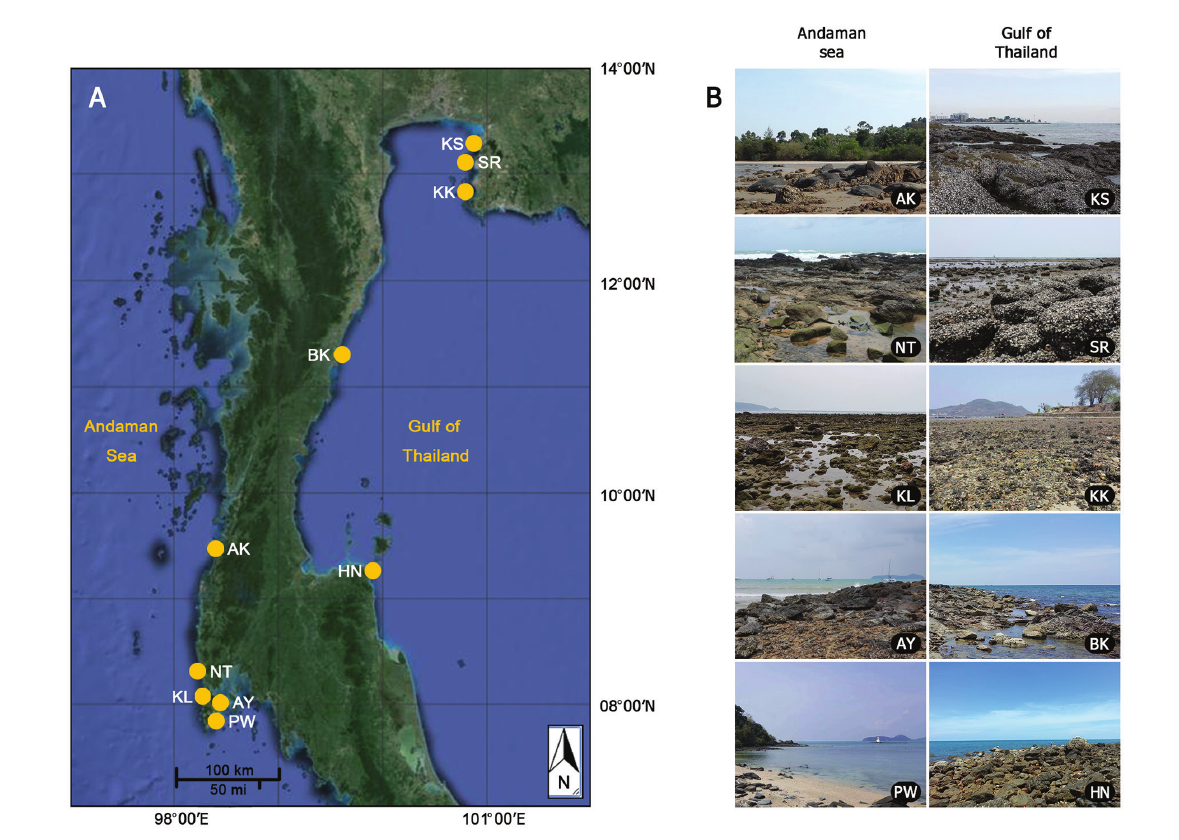
Figure 1. Map showing all sampling locations ( A ) and habitat characteristics ( B ) of acorn barnacles found along the coastlines of the An- daman Sea and the Gulf of Thailand. See Table 1 for acronyms of sampling sites. (modified from